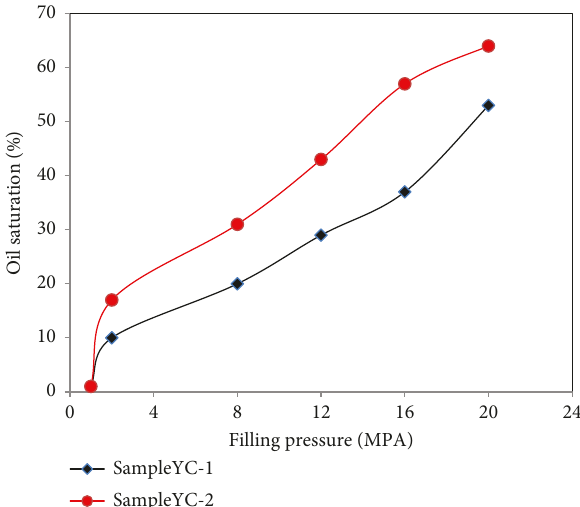
Figure 3: The relationship between filling pressure and oil satu- ration is gradually increasing.